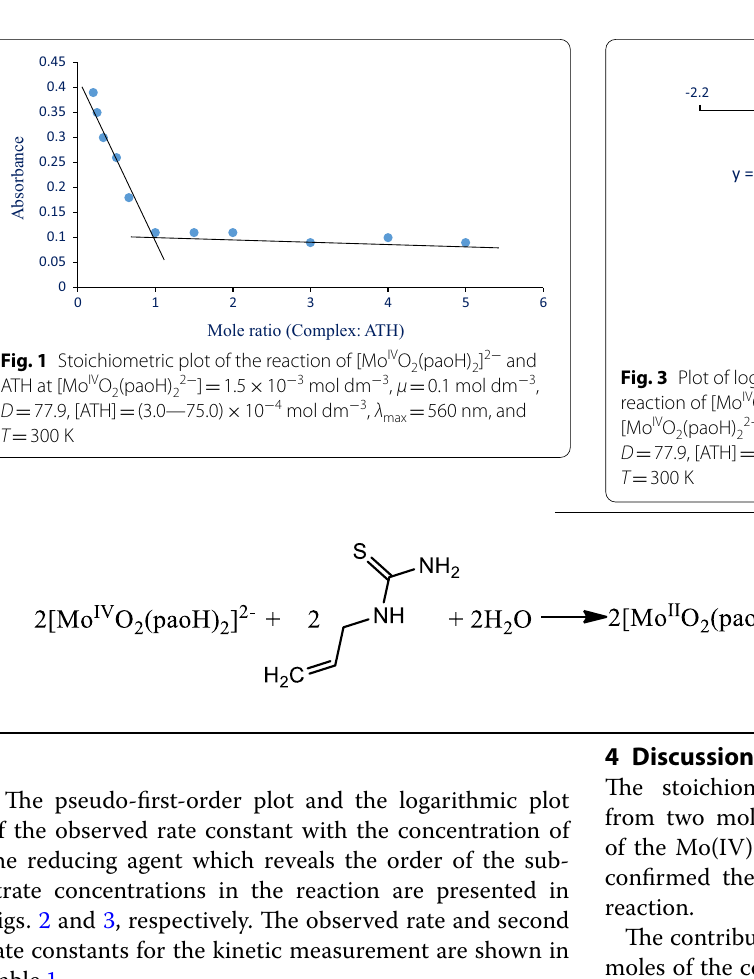
1.5 10 − 3 mol dm − 3 , µ = ×